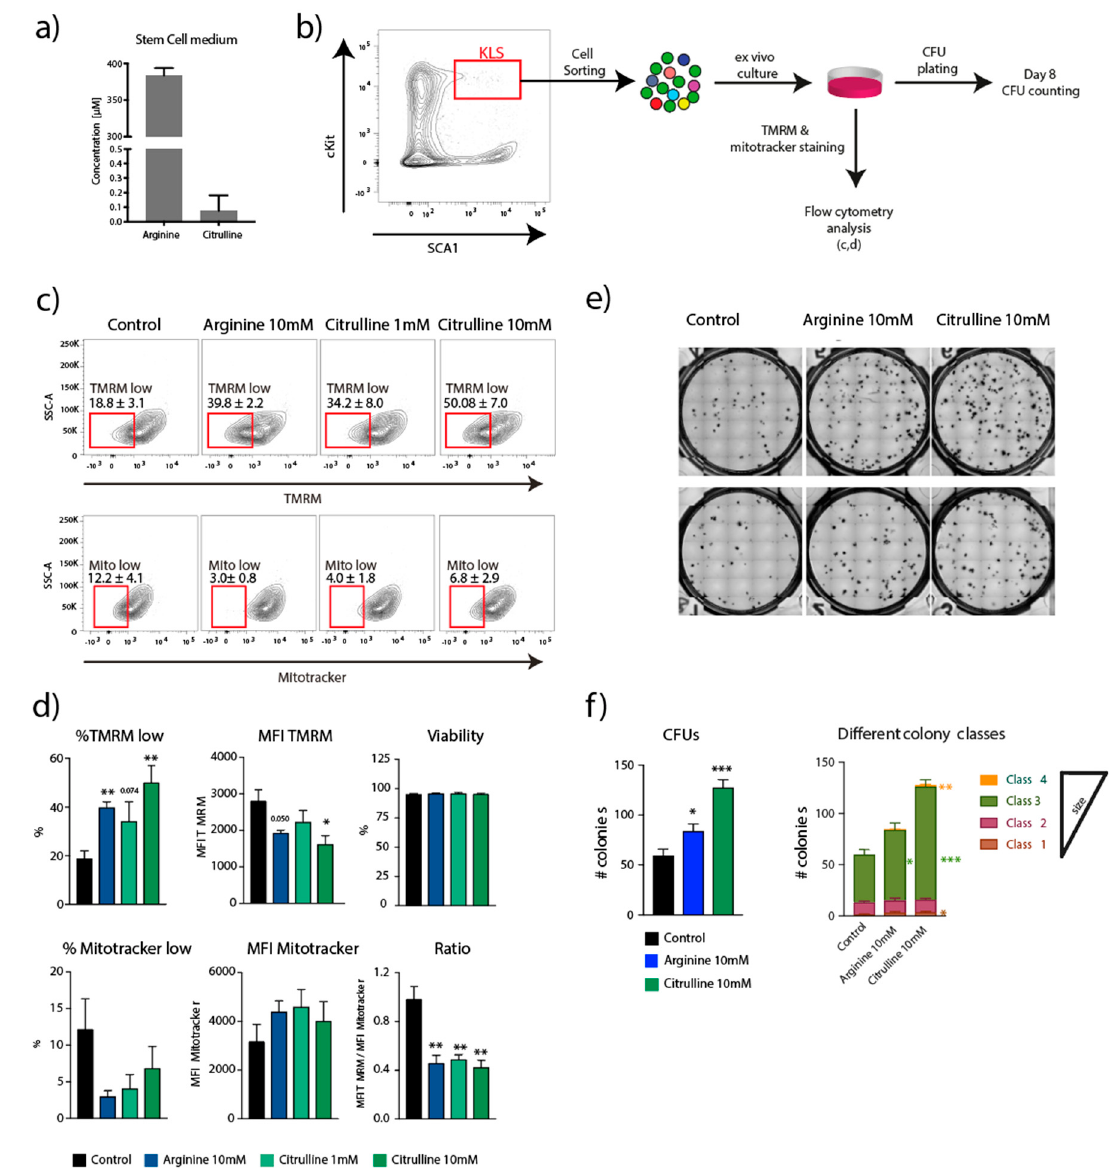
Figure 3. Ex vivo culture of HSPCs (KLS) with Urea cycle intermediates. ( a ) Measurement of arginine and citrulline concentration in stem cell media. ( b ) FACS sorting of KLS population for ex vivo culture in 96 well round bottom plates, followed my TMRM and Mitotracker staining for FACS analysis, and CFU plating. ( c ) Contour plots showing TMRM and Mitotracker levels in di ff erent conditions ( d ) Estimation of Viability of cells post culture, TMRM and Mitotracker low population and Mean Fluorescence intensity (MFI) of TMRM and Mitotracker. ( e ) Representative images of CFU wells at Day 8 from control, arginine (10 mM) and citrulline (10 mM) conditions. ( f ) Estimation of colony counts and di ff erent colony classes as identified by STEMvision analyzer software. Student t -test * p < 0.05, ** p < 0.01, *** p < 0.001, **** p < 0.0001 ( n = 4).